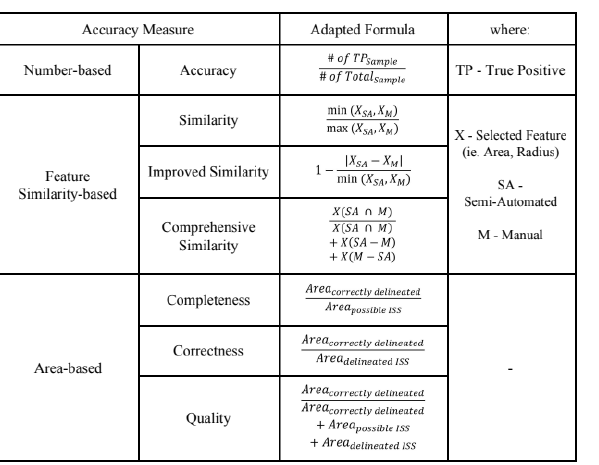
Table 1. Summary of accuracy measures adapted for the